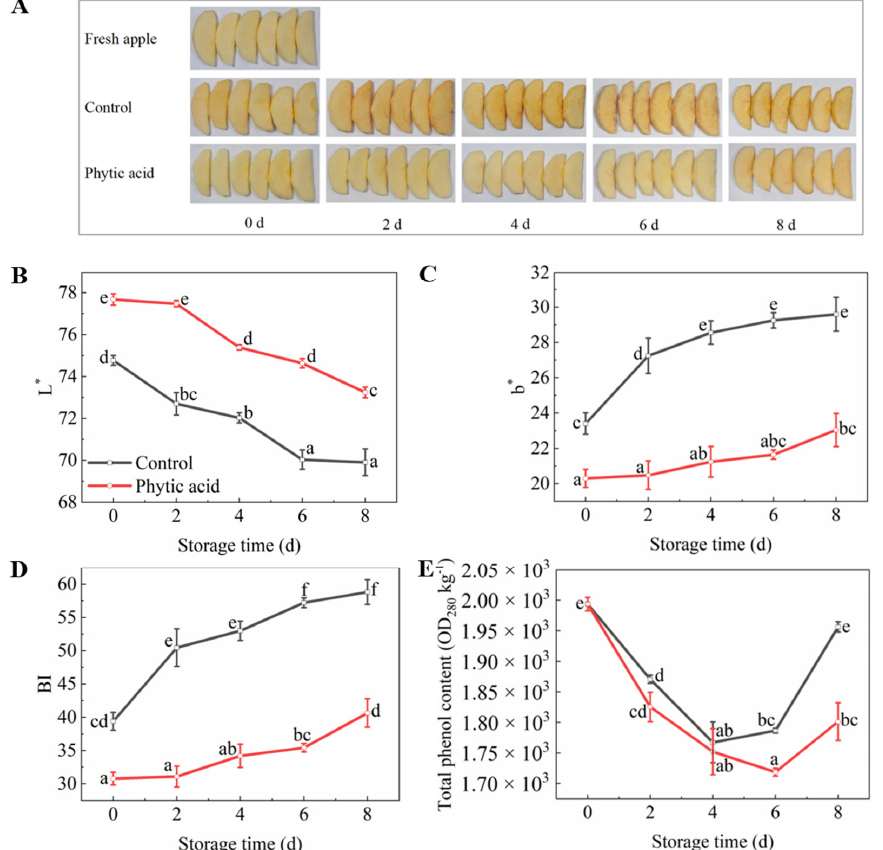
Figure 2. Photos and color parameters of fresh-cut apples during storage after treatment with phytic acid or the control. ( A ) Photos; ( B ) L* ; ( C ) b* ; ( D ) BI; ( E ) Total phenol content. The ‘Fresh apple’ represents unsoaked apple slices. Vertical bars represent standard errors of the means of three replicates. The different letters indicate significant differences at p < 0.05.